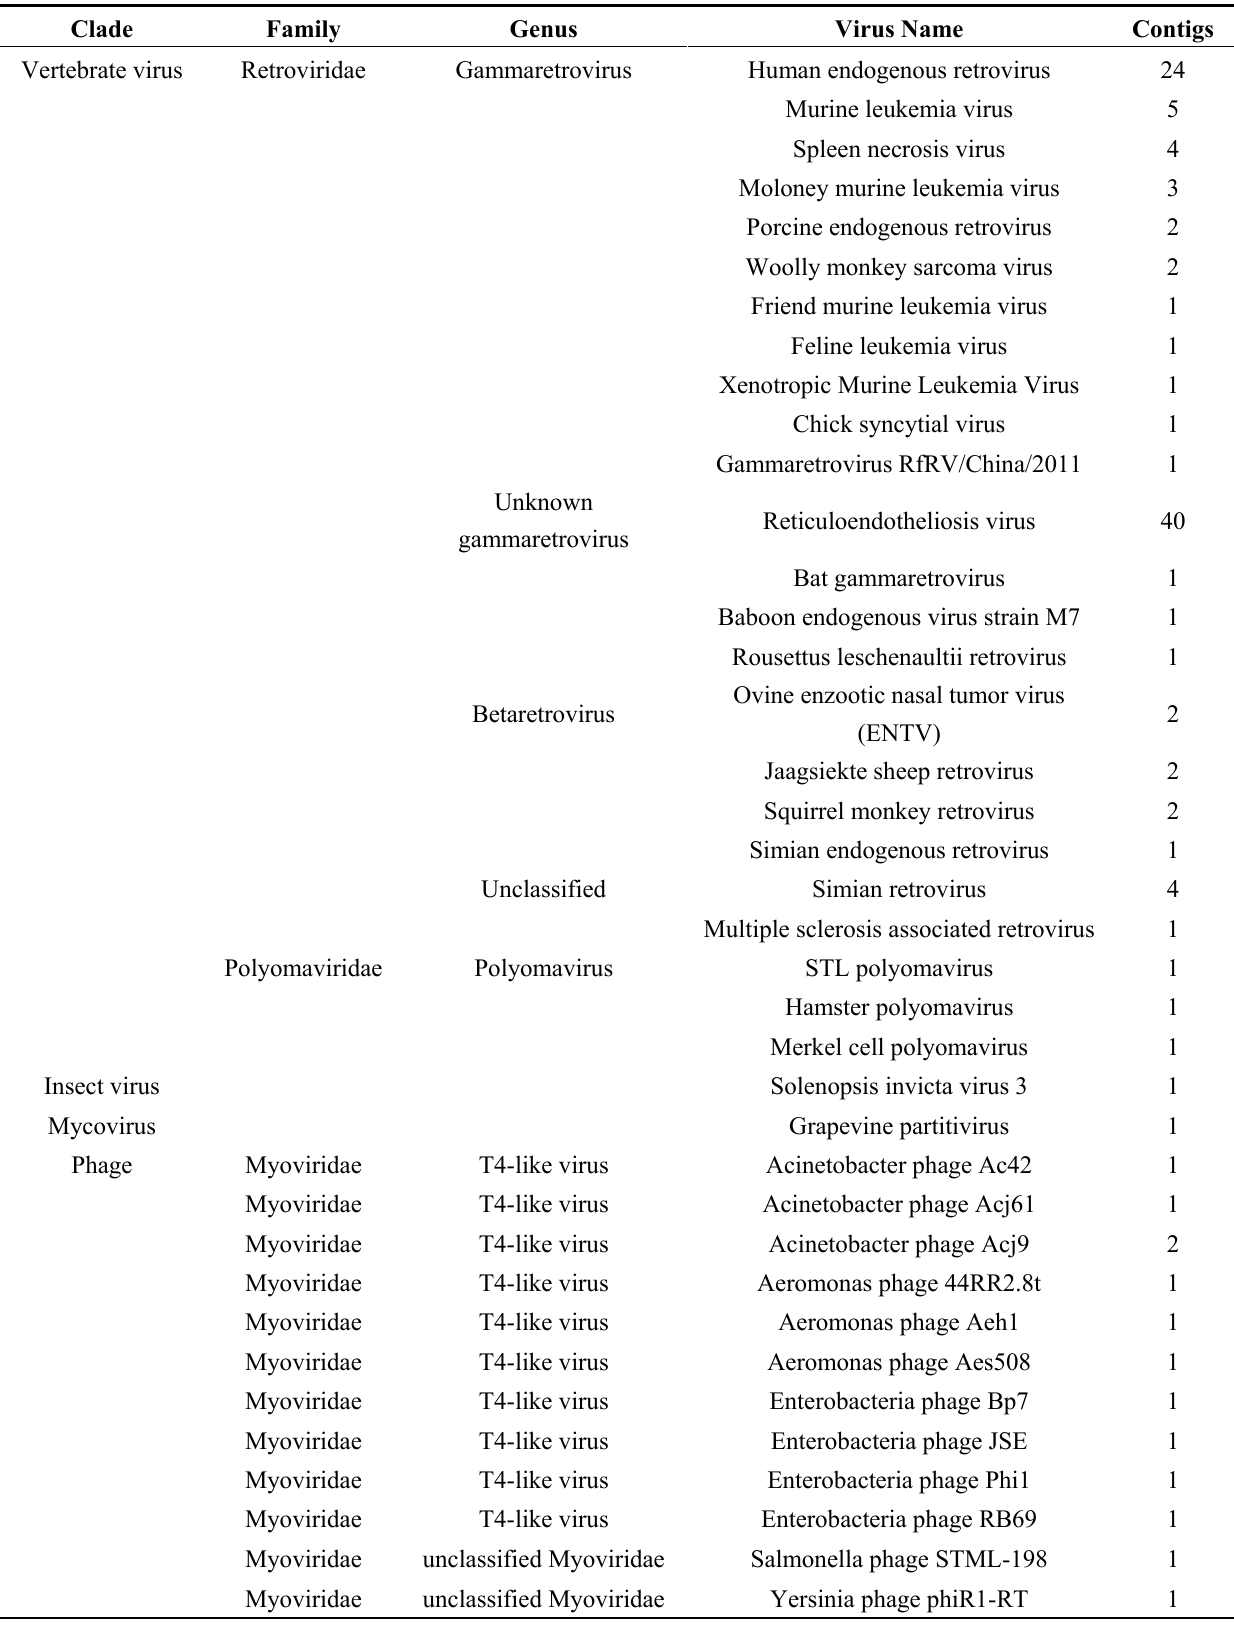
Table 1. Details of assembled contigs related to eukaryotic viruses and phages as determined with Blastx and the GenBank database. Detailed information is shown in Table